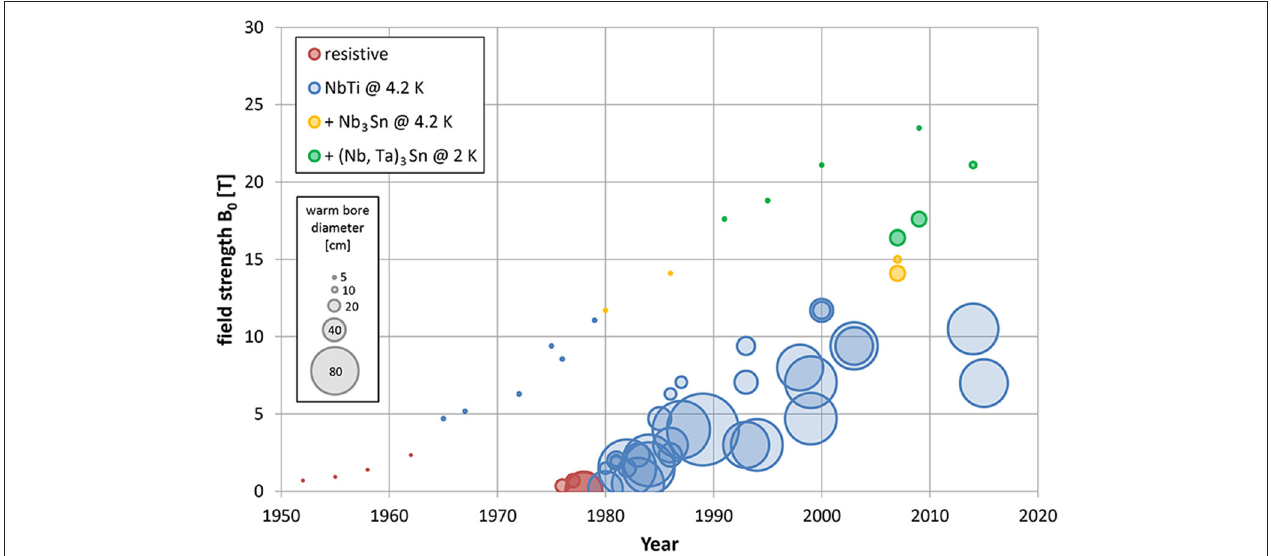
FIGURE 1 | Increase in field strength (and bore diameter) of commercially available NMR systems for analytical (points, left), biomedical and preclinical (small circles, middle), and human MRI and MRS (big circles, right). Please note the rather similar slopes of the analytical NMR and preclinical MR development, which are delayed in time by 15 years. Both preclinical and human MR magnets started to evolve with the availability of reliable superconductor technology around the year 1980. The ∼ slope for human magnet development is less steep, likely due to costs (size of the magnet) and legal constraints (slowly increasing upper legal limits for field strength in vivo ). References for all data points are given in the Supplementary